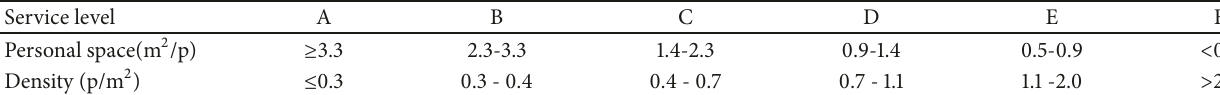
Table 5: Service level.